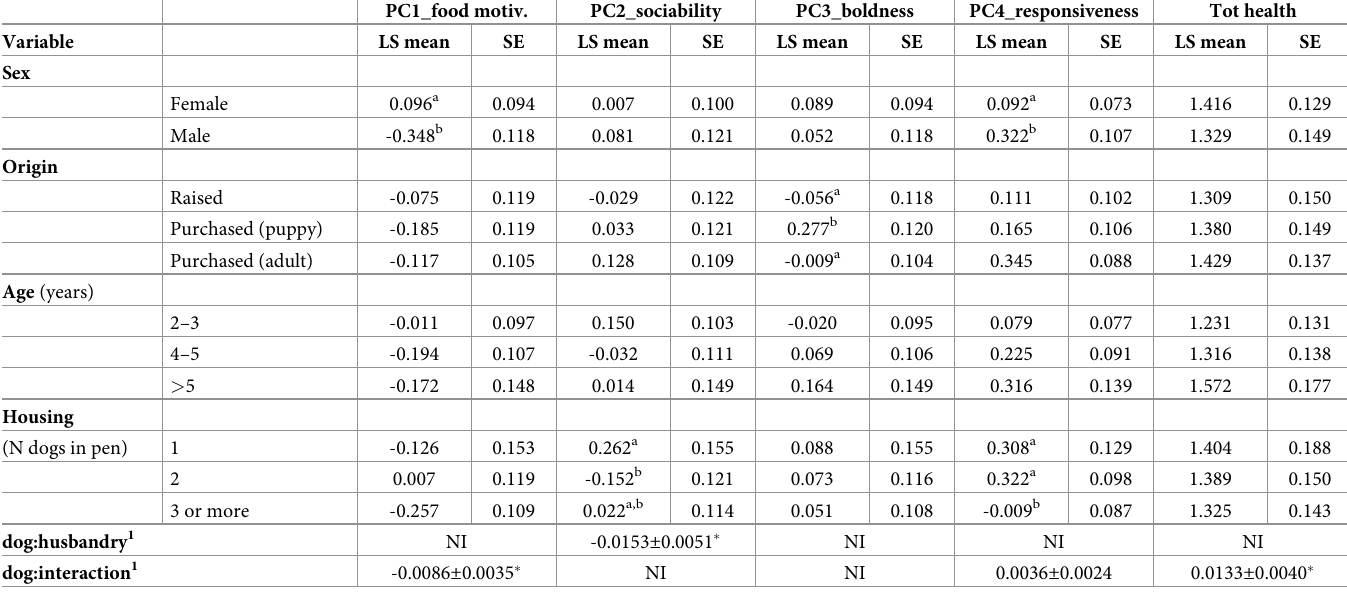
Table 4. Least squares means (LS mean) and SE of the effect of sex, origin, age, housing, dog:husbandry ratio and dog:interaction ratio on PC scores and total health.